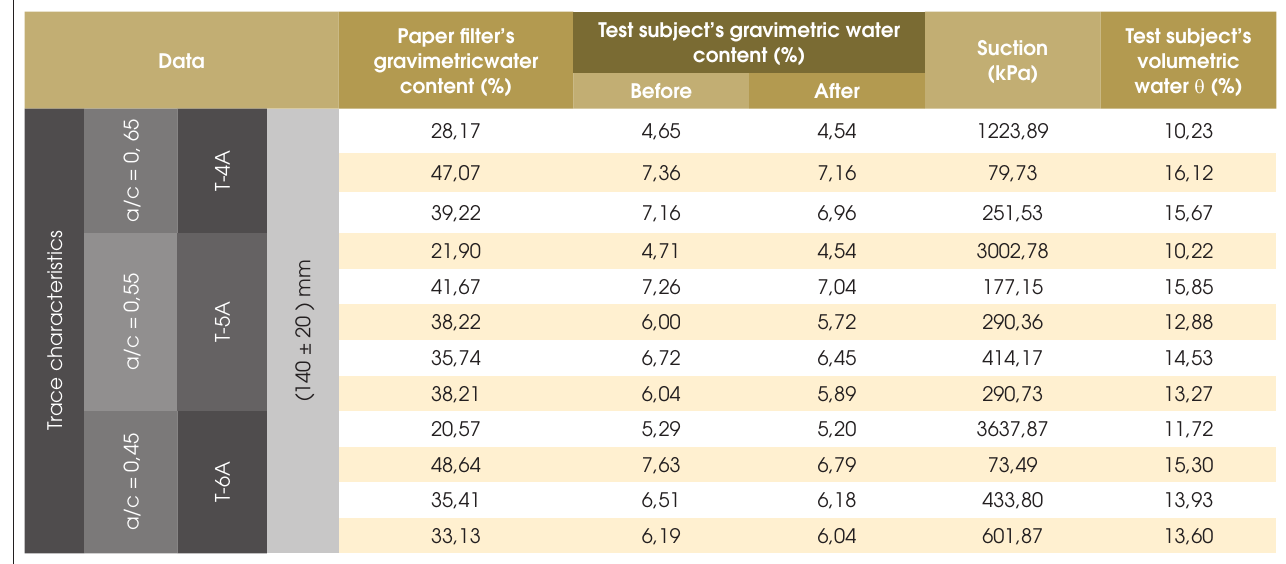
Table 5 – Suction test results for concrete test subjects